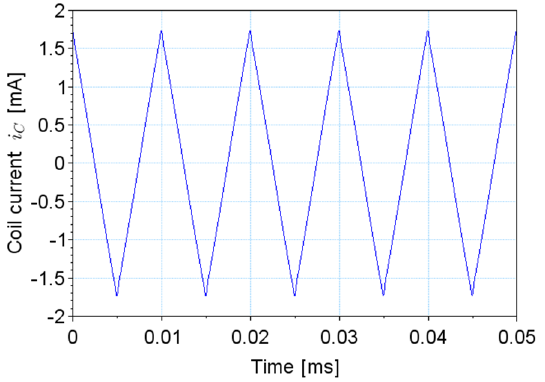
Figure 15. Inductor current i c waveform for the case with a rectangular voltage source.